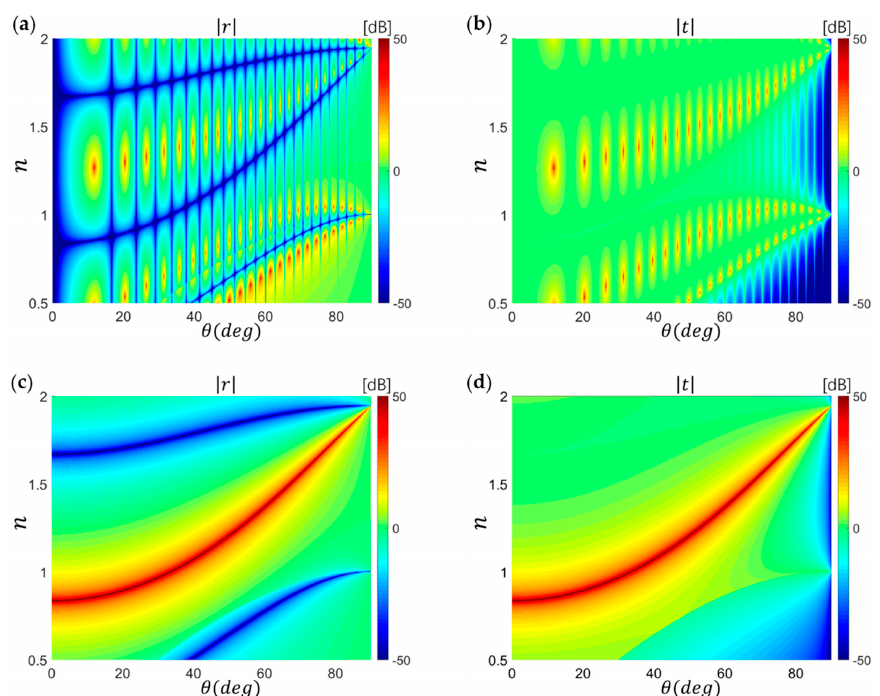
Figure 5. The absolute amplitude of the reflection | r | ( a ) and transmission coefficient | t | ( b ) as a function of the variables θ and refractive index n of the PIM-air-PIM* structure. The absolute amplitude of the reflection | r | ( c ) and transmission coefficient | t | ( d ) as a function of the variables θ and refractive index n of the PIM* slab.